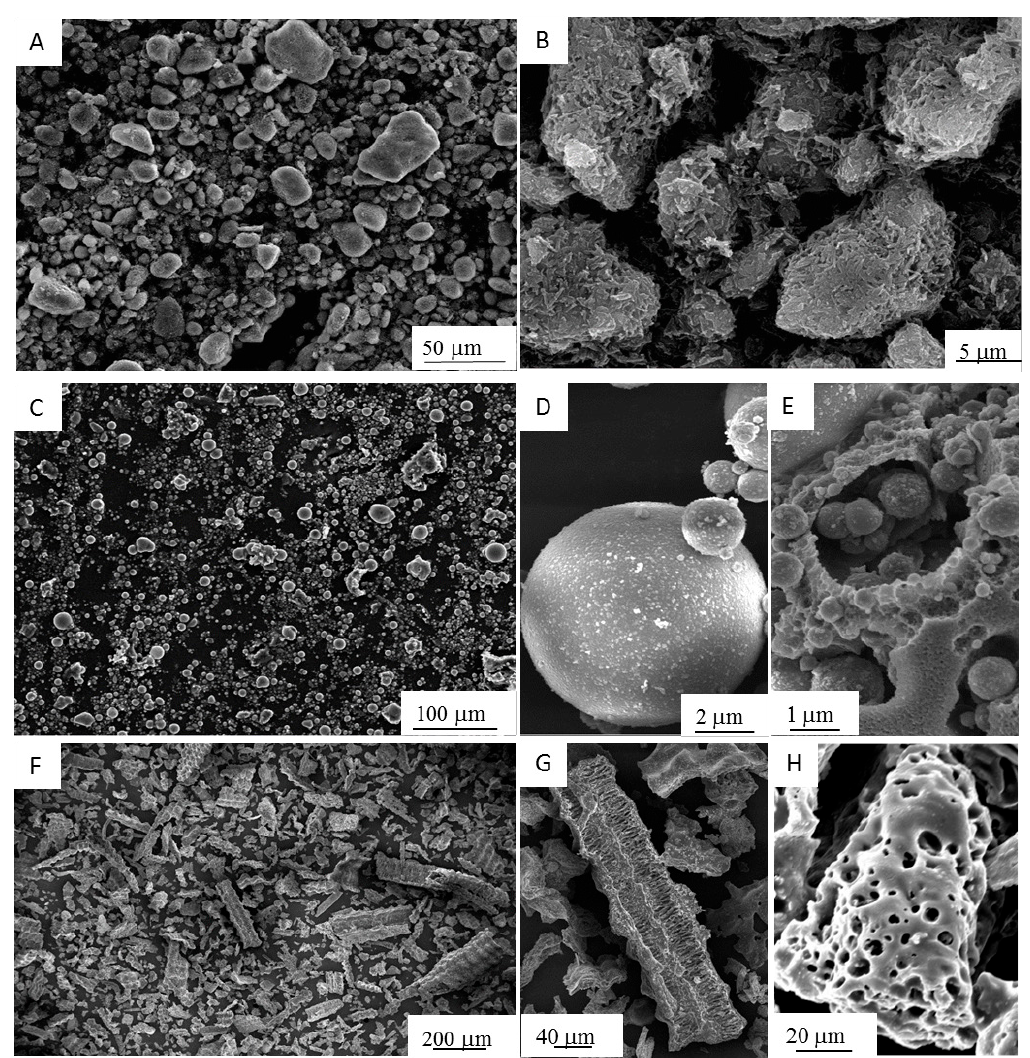
Figure 2. FESEM micrographs of raw materials: ( A , B ) calcined HL; ( C – E ) FA; ( F – H ) RHA.